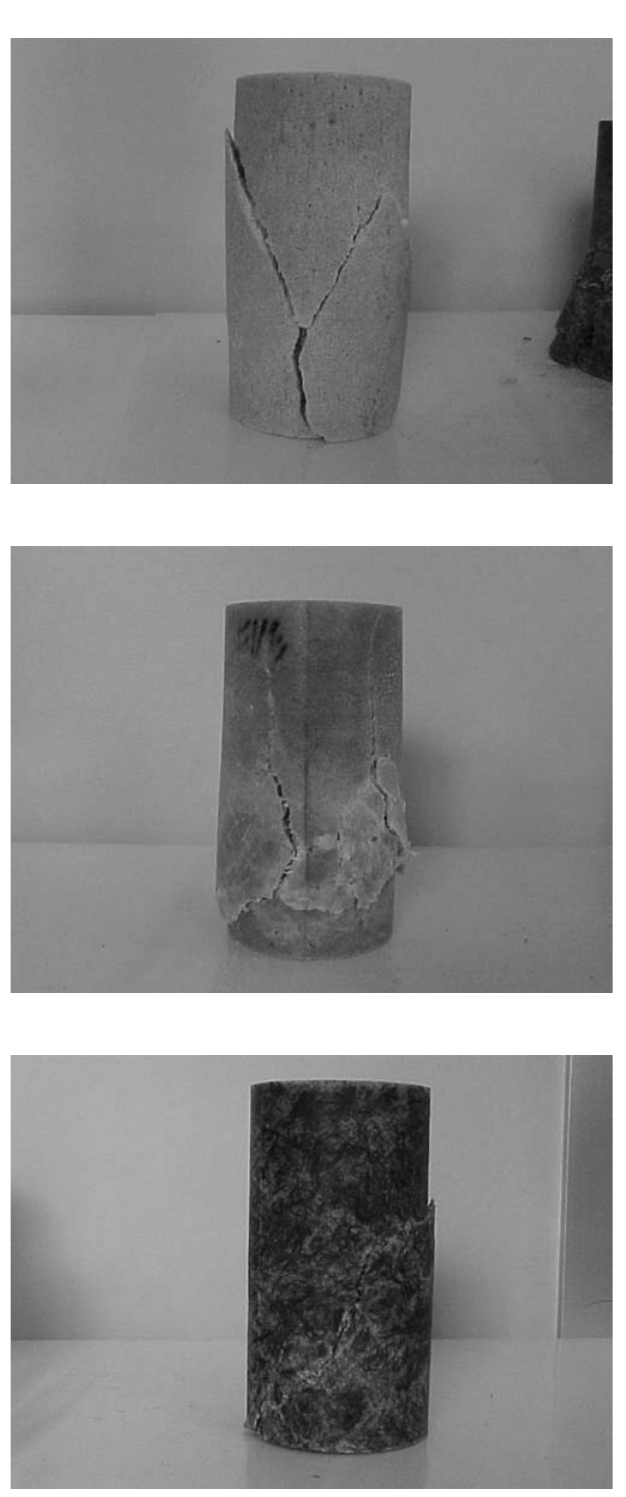
Figure 3. Epoxy, Glass and Carbon Fiber Polymer Concrete Specimens after